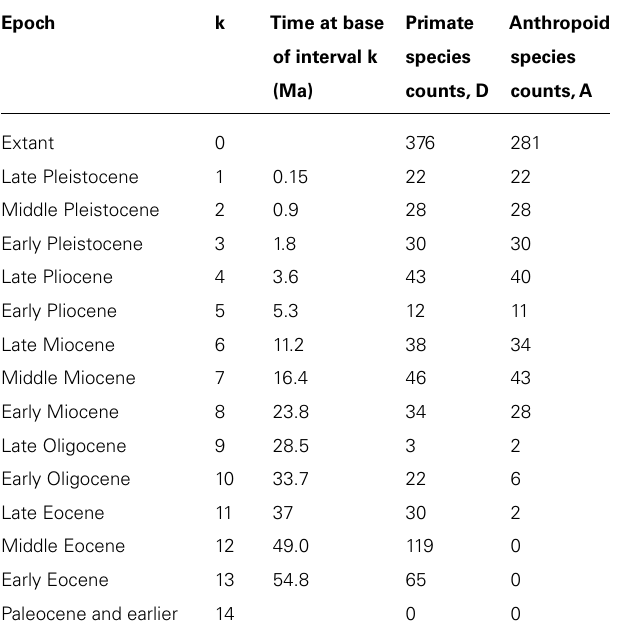
Table 1 | Number of primate and anthropoid species that are extant or known from the fossil record used in the example ofWilkinson andTavaré (2009). Geological time is divided into 14 intervals